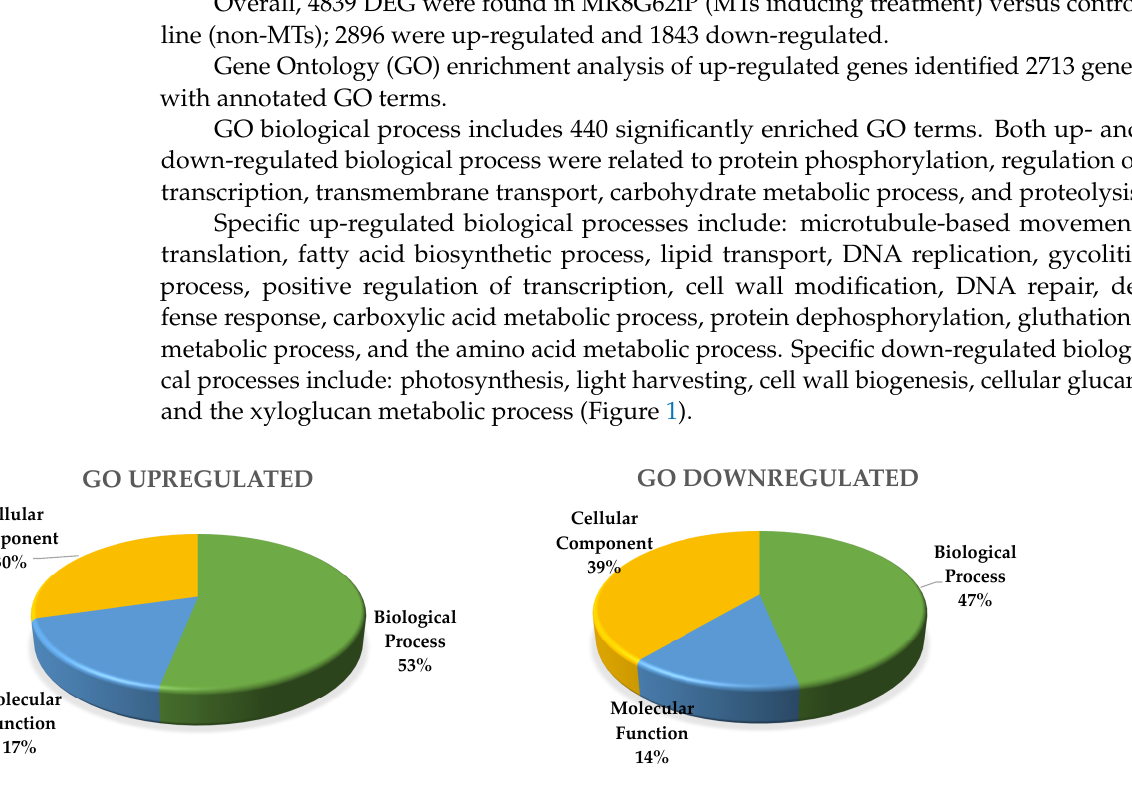
Figure 1. Biological process regulated during MTs development of potato induced in dark.